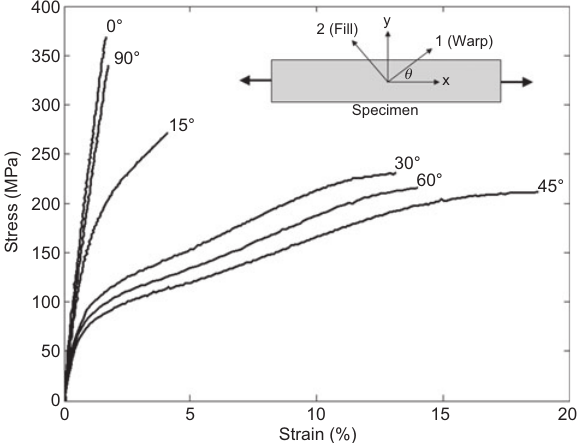
Figure 3 Stress vs. strain data for woven E-glass/vinyl ester laminate.